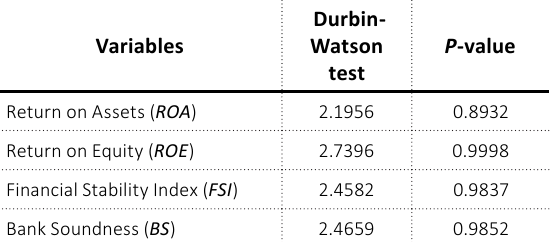
Table 2. Serial correlation test amongst the variables